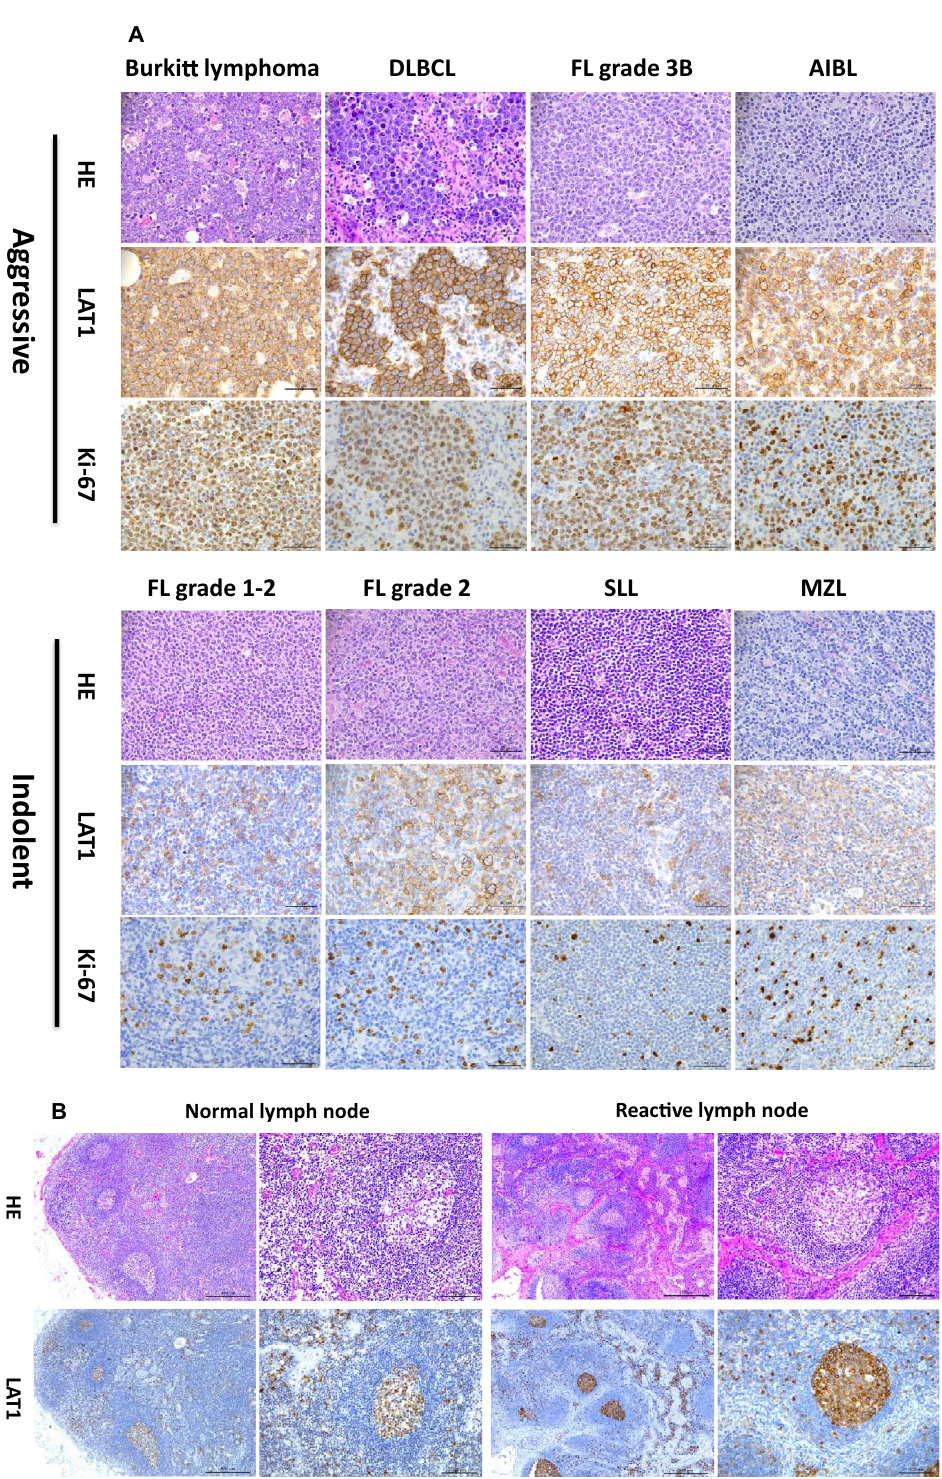
Figure 1. Representative images of Immunofluorescence double staining of lymphoma cells. ( A ) Representative images of HE staining, LAT1 and Ki-67 immunohistochemistry staining in selected cases of aggressive and indolent lymphomas. Aggressive lymphomas (Burkitt lymphoma, Diffuse large B-cell lymphoma (DLBCL), Follicular lymphoma (FL) grade 3B, Peripheral T-cell lymphoma (PTCL)) and indolent lymphomas (Follicular lymphoma (FL) grade 1–2 and grade 2, Small lymphocytic lymphoma (SLL), Marginal zone lymphoma (MZL)). Aggressive lymphomas on the upper row expressed higher levels of LAT1 than indolent lymphomas on the lower row. LAT1 expression levels and patterns were different on the classification of lymphoma aggressiveness. ( B ) LAT1 staining in the normal lymph node and reactive lymph node as negative controls. Normal lymphocytes did not express LAT1 excluding some activated lymphocytes in the germinal center of the follicle and medulla area. On the other hand, many lymphocytes, especially in the germinal center area, were strongly positive for LAT1 in reactive lymph node tissue. Scale bars indicate 50 µm (zoomed) or 500